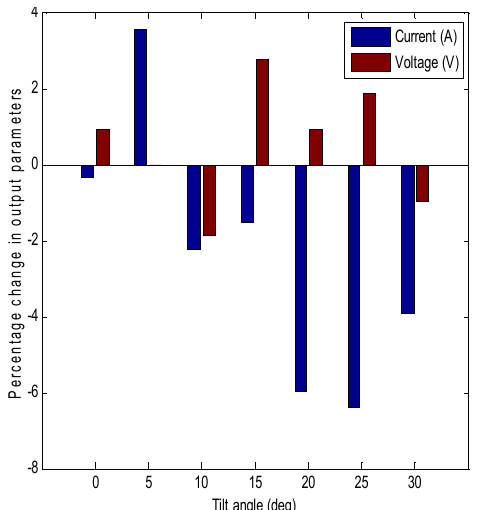
Figure 6(b). Percentage change in output parameters (Current and Voltage) with tilt angle for increases in ground albedo from 0.07 to 0.75 at Chennai